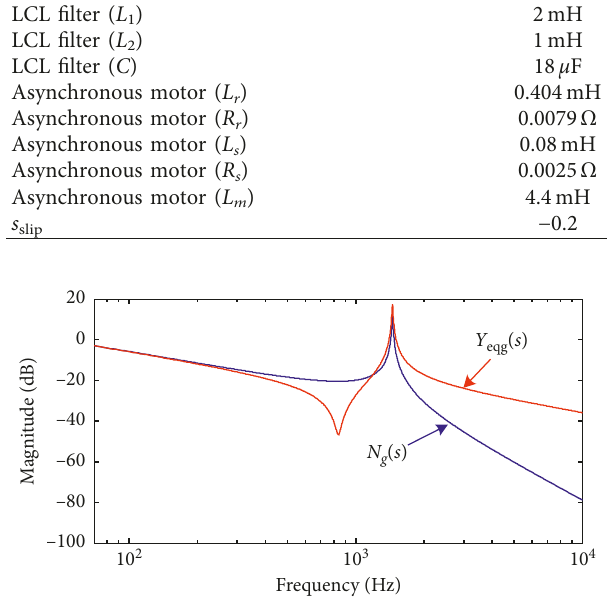
Figure 6: Magnitude-frequency curves of N